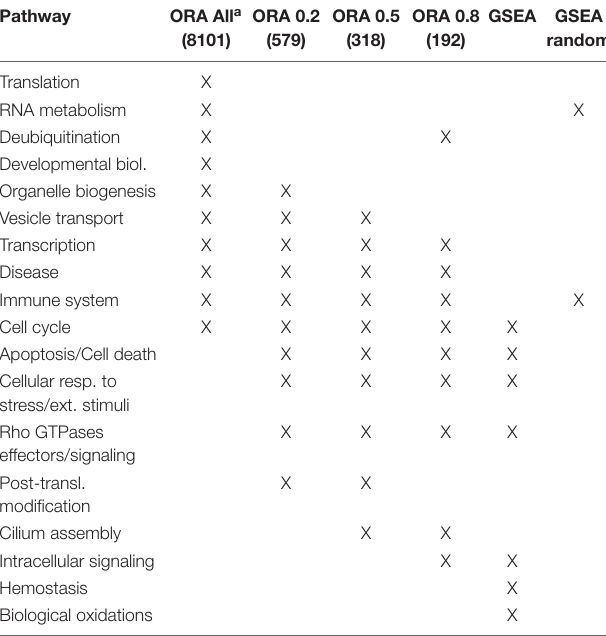
TABLE 3 | Comparison of enriched pathways.